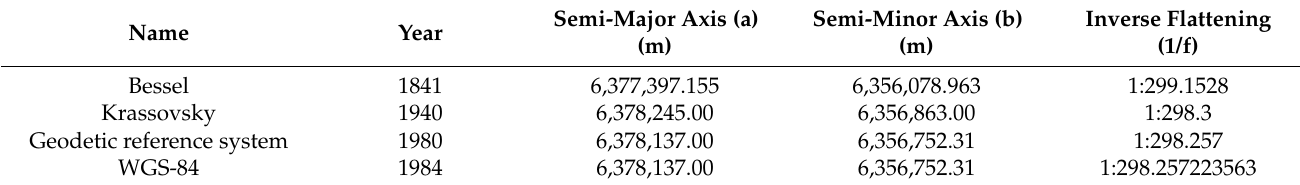
Table 3. Difference between chart datum reference ellipsoids